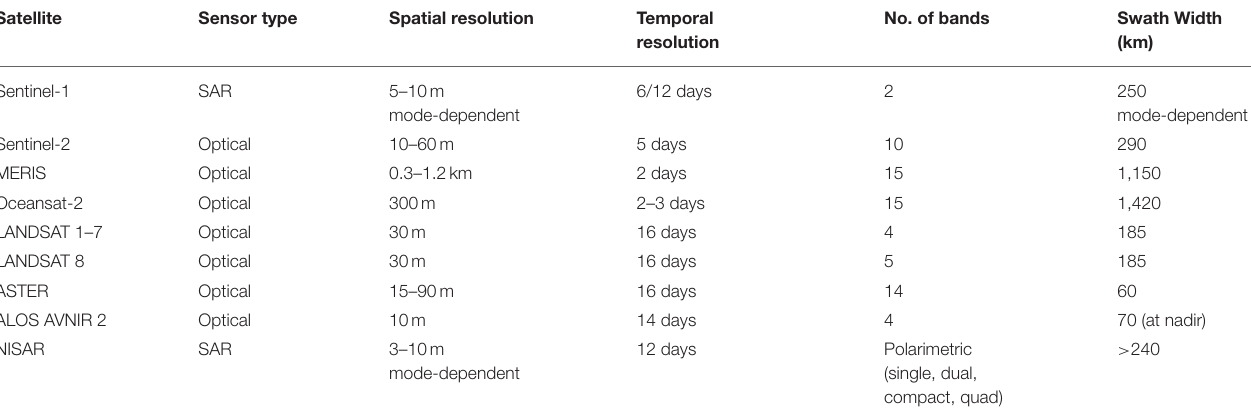
TABLE 1 | Salient features of open access satellite-based sensor systems that can potentially be used for monitoring water hyacinth infestation.